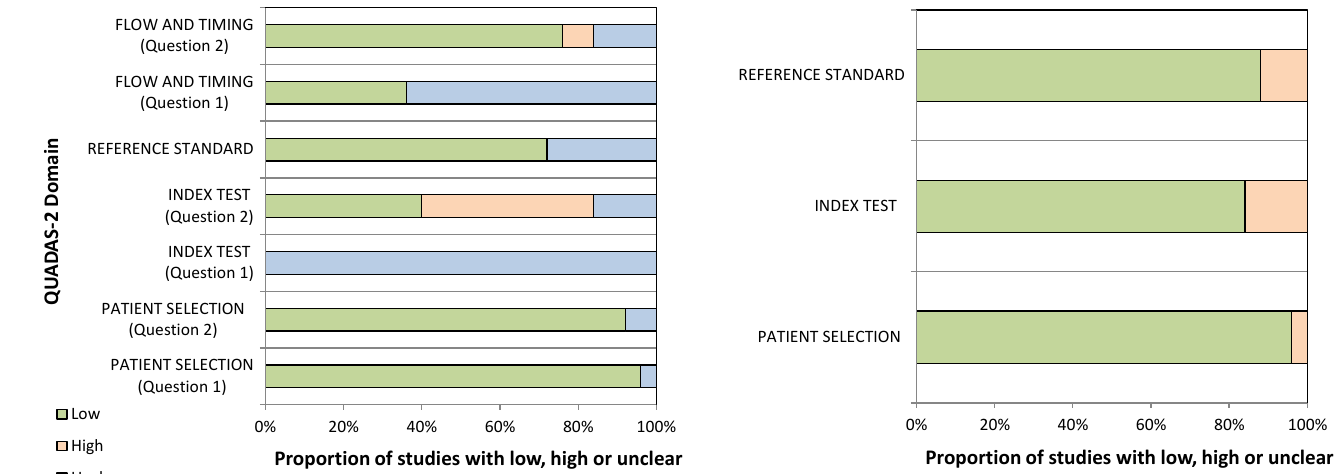
Figure 2 . Graphical display for the QUADAS-2 results. Figure 2. Graphical display for the QUADAS-2